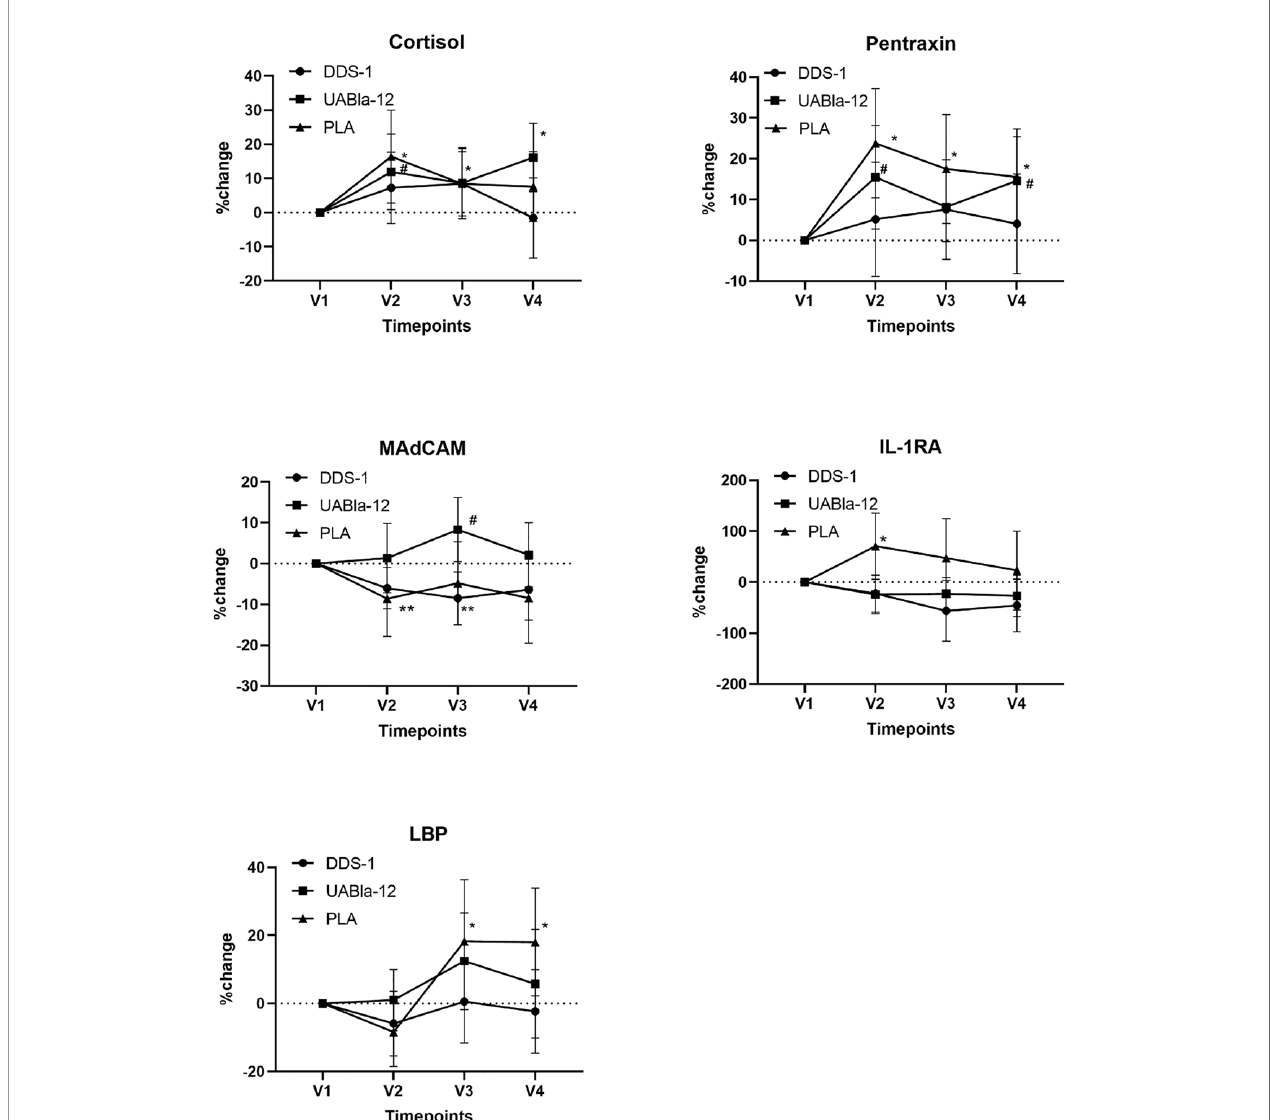
FIGURE 2 | Changes in the concentration of serum analytes over the course of the study. Signi fi cantly larger within group changes in the placebo group are evident in all analytes from V1 to V2. Data are % change and 95% CI. The large changes in these analytes while adhering to typical night-day sleep-wake cycle were greater than the effect of nightshift on indices of stress, the acute phase response, serum cytokines and intestinal integrity markers. *signi fi cant change from V1 in the placebo group, # signi fi cant change from V1 in UABla-12 group. **signi fi cance chance from V1 in the DDS-1